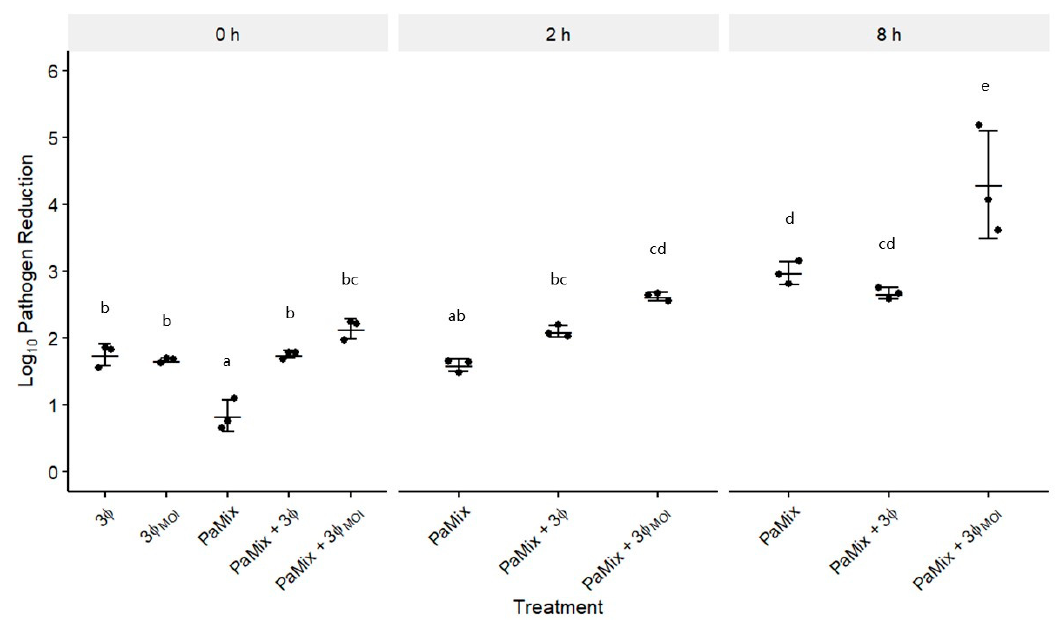
Figure 6. Effect of a designed MOI on the efficacy of PaMix and phage treatment at controlling E. amylovora . Treatments were grown for 0 (co-inoculated), 2, or 8 h before EaMix inoculation. The three phages φ Ea21-4, φ Ea46-1-A1, and φ Ea35-70, each at an MOI of 1 (3 φ ) or at 10, 1, and 0.01, respectively, (3 φ MOI ) were tested alone at 0 h or with PaMix at each time comparison. E. amylovora populations were measured 24 h after inoculation, and reduction was relative to EaMix growth alone. Data are the mean ± SD of three replicates.